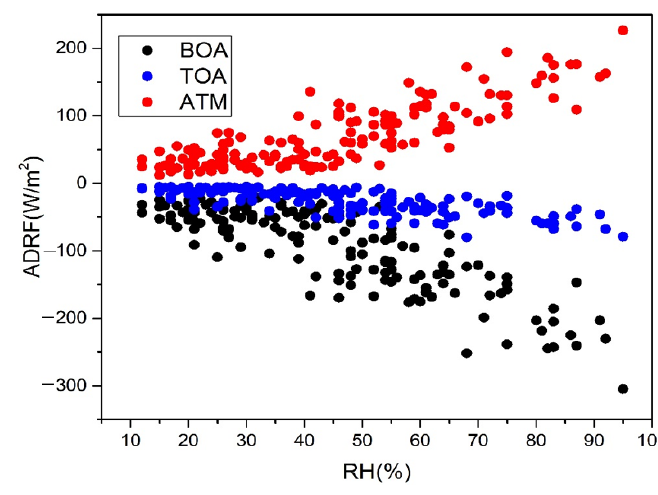
Figure 9. Correlation analysis of ADRF and RH.